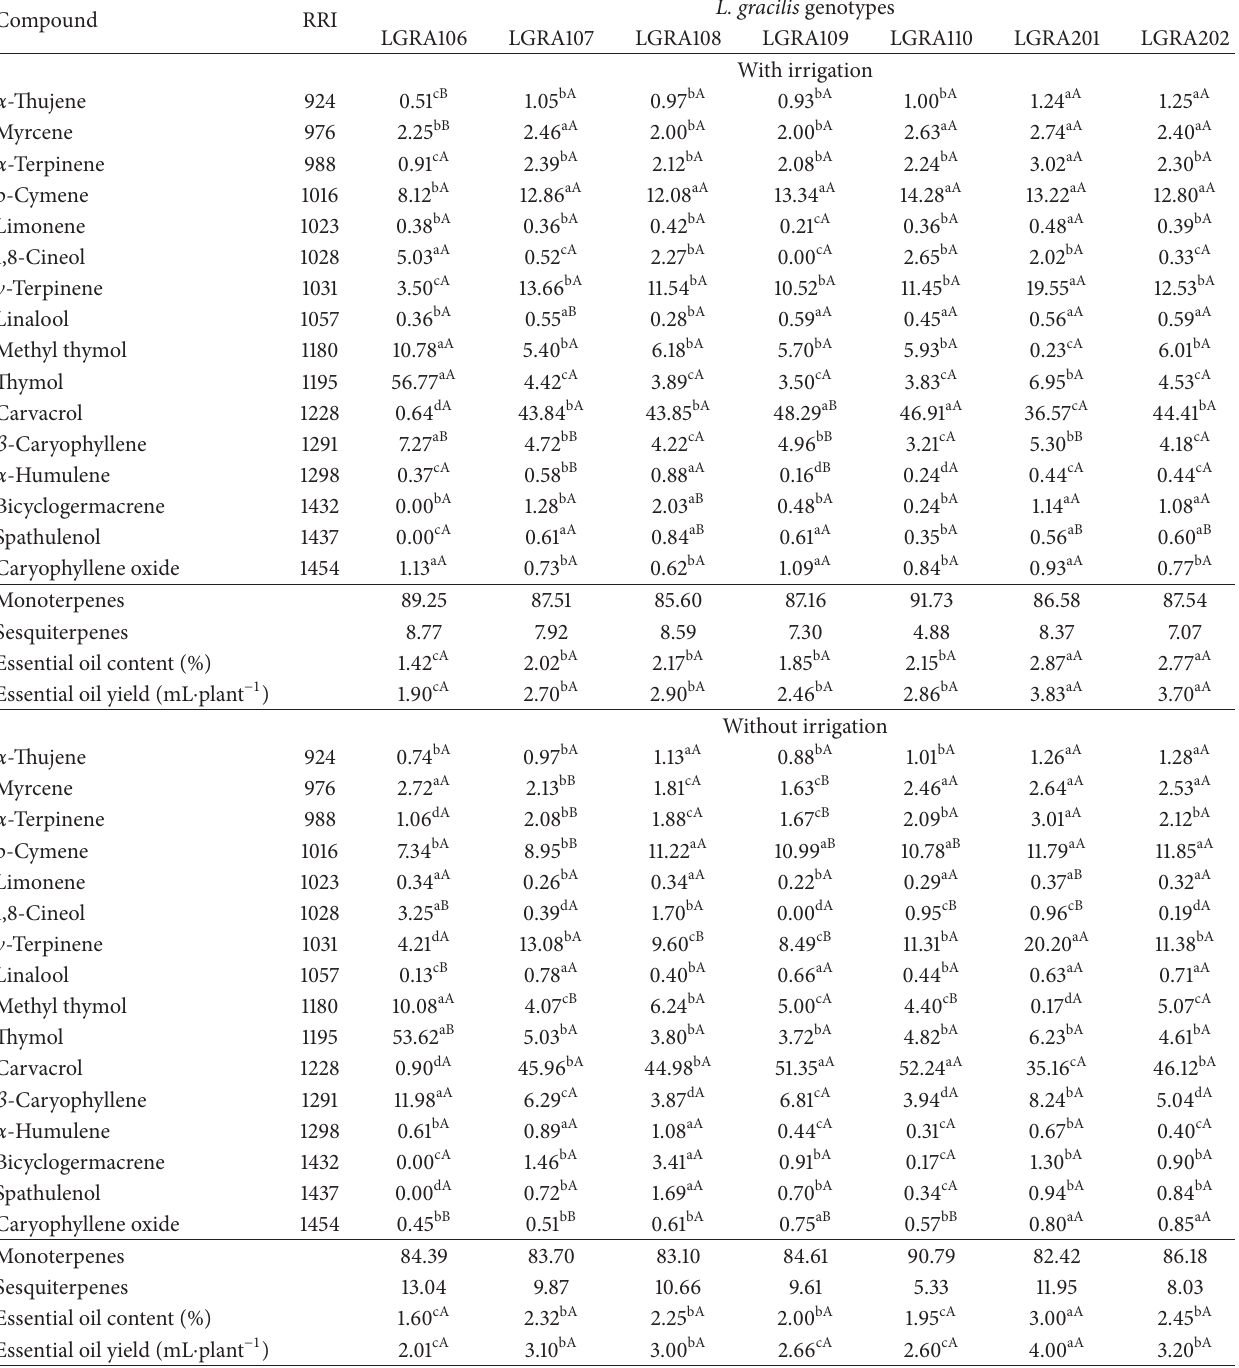
Table 3: Chemical composition (%) of the essential oil of L. gracilis genotypes cultivated with and without irrigation.